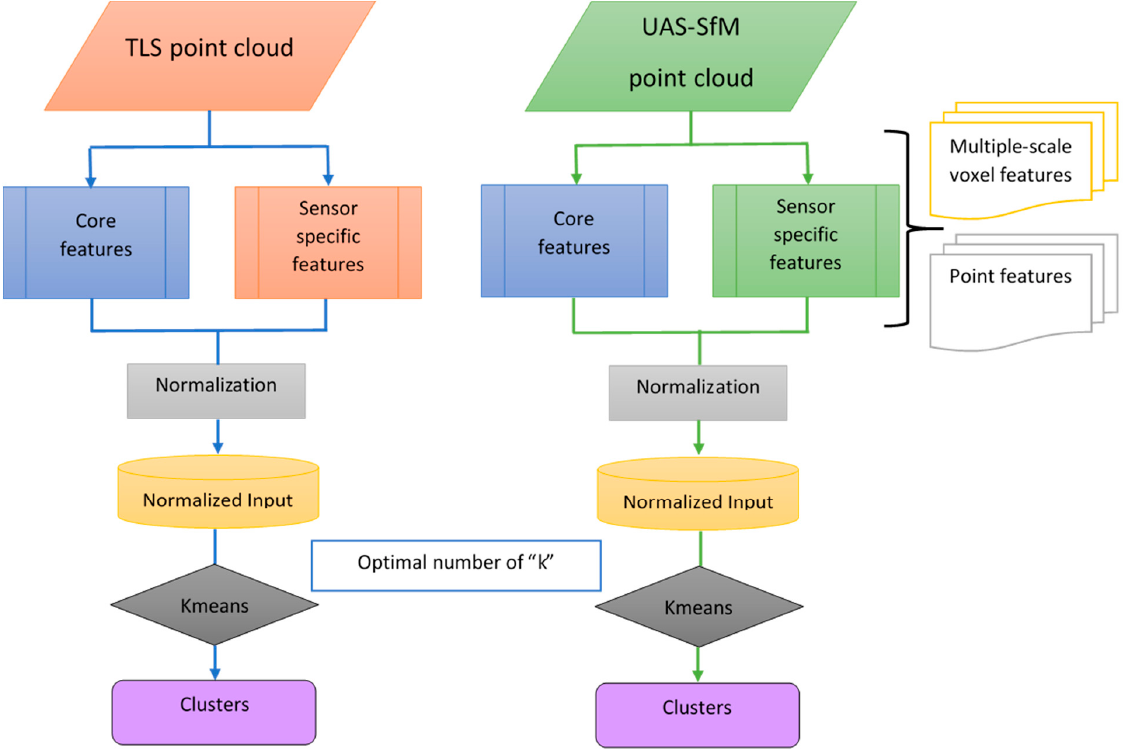
Figure 4. Summary of the entire clustering framework.